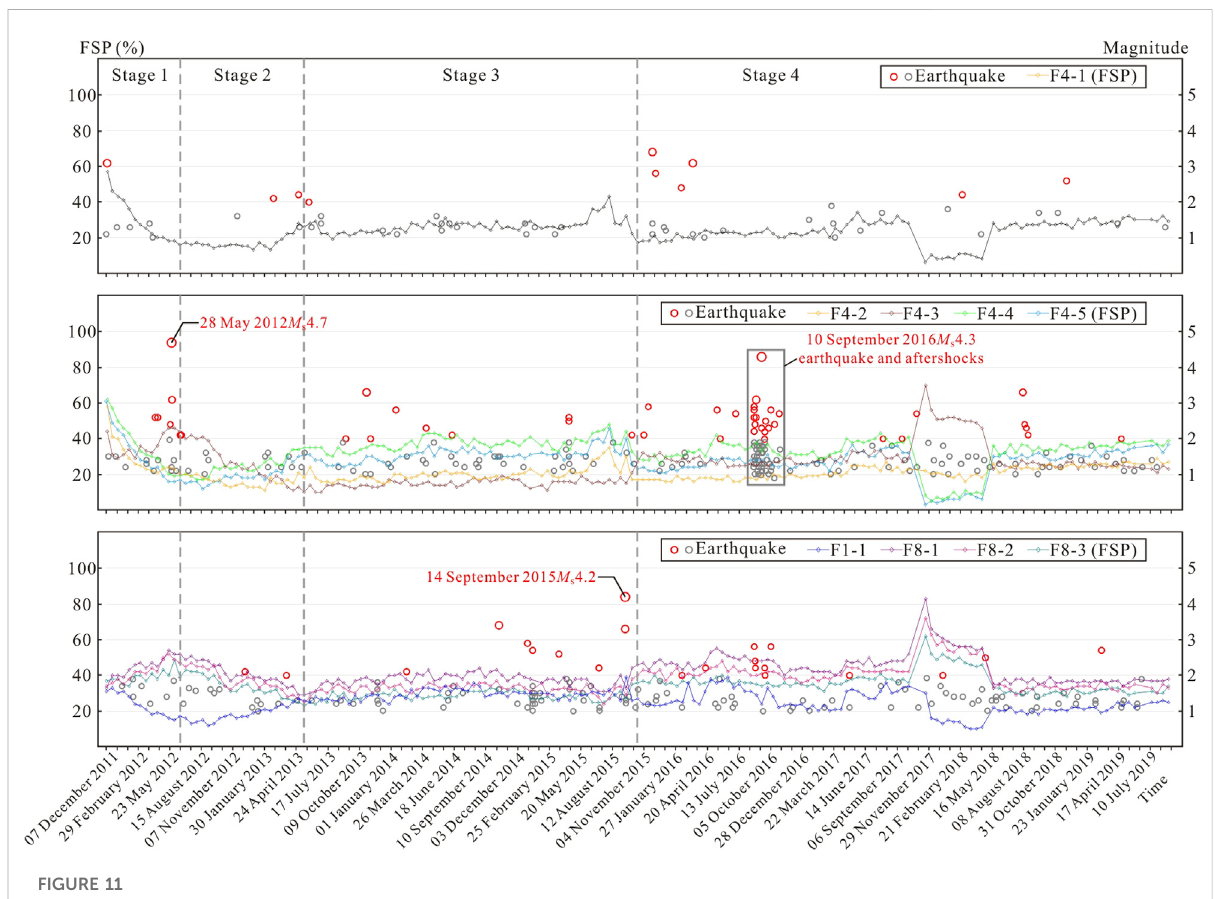
FIGURE 11 Variation of FSP value of major seismogenic faults with